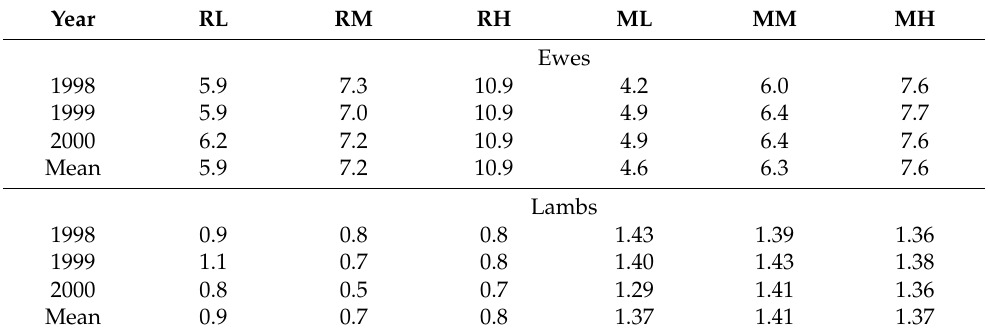
Table 2. Mean stocking (ewes/ha) and lambing rates (lambs/ewe) for different grazing systems from 1998 to 2000. (Note: The mean values for each system used for